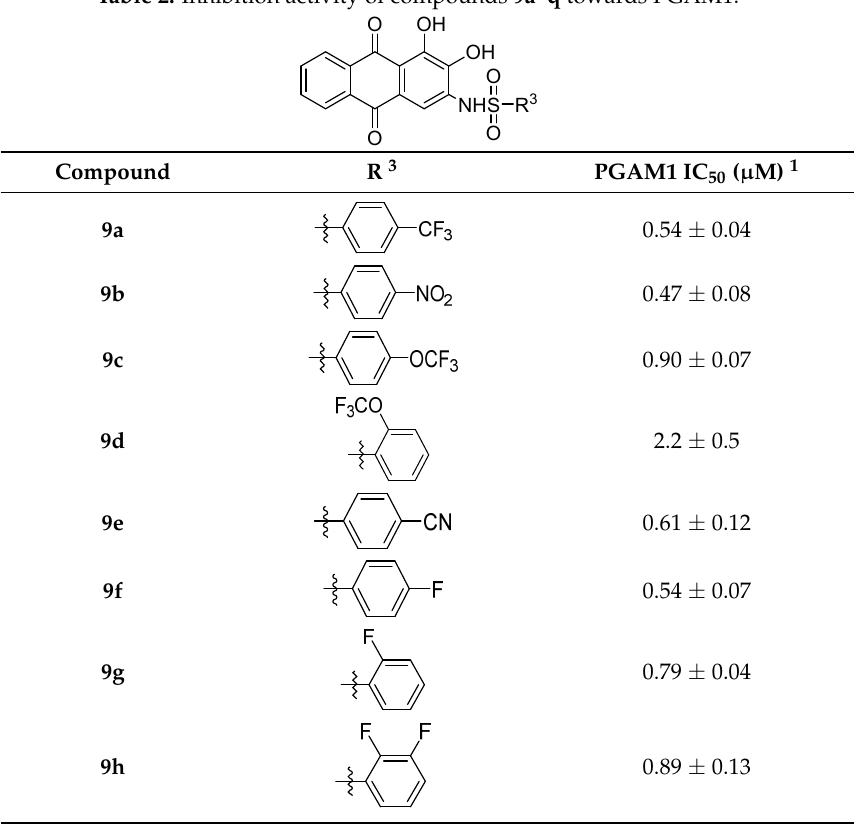
Table 2. Inhibition activity of compounds 9a – q towards PGAM1.